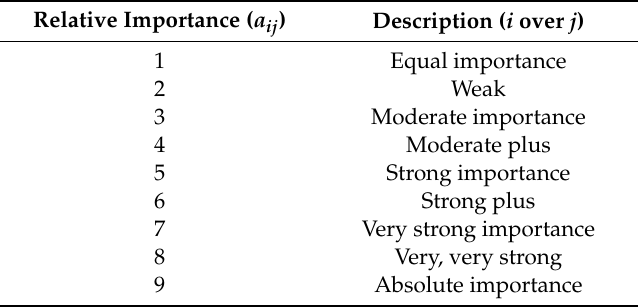
Table 1. Pair comparison evaluation scale (Saaty’s scale) [11,12]. Relative Importance ( a ij ) Description ( i over j ) 1 Equal